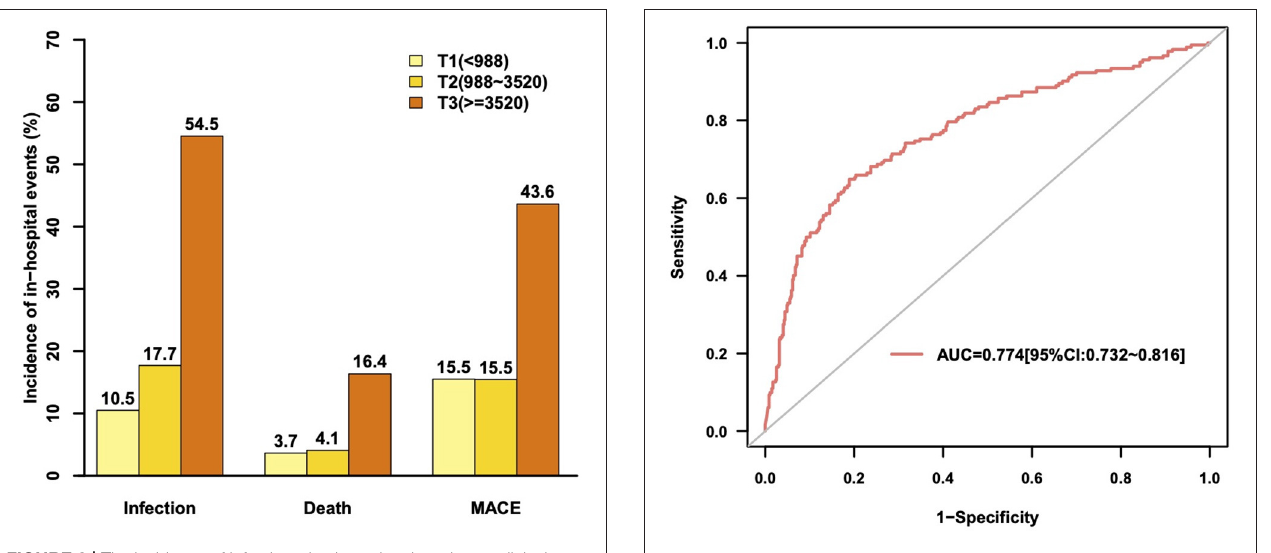
FIGURE 2 | The incidence of infection, death, and major adverse clinical events during hospitalization. TABLE 2 | Independent risk factor of infection based on multivariate analysis.